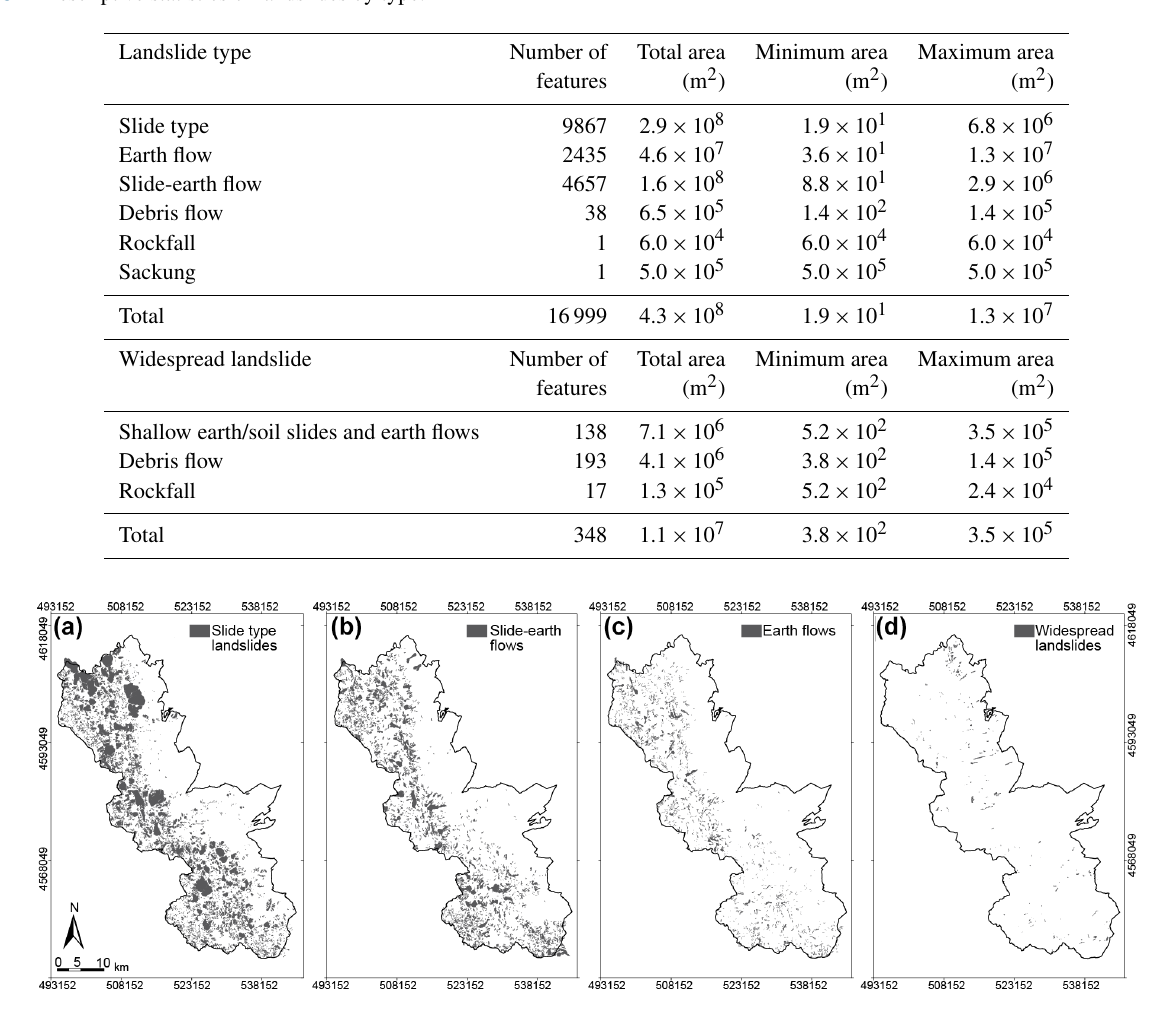
Sect. 4.4). Finally, sackungs are poorly represented in